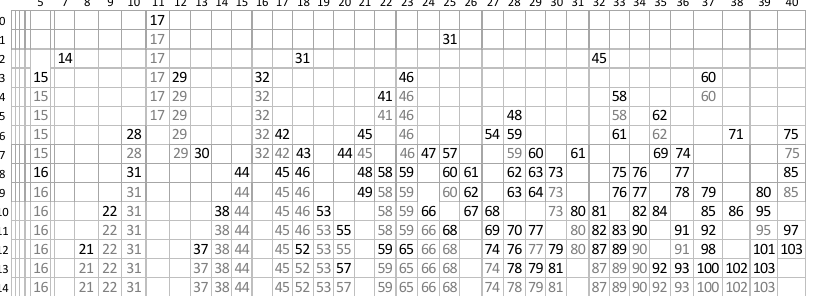
Figure 6. An example ( n = 15, C = 40) of initial reduction (15 × 40-array (=600) to e-nodes (=223)) and original e-nodes (=103) after F-reduction.